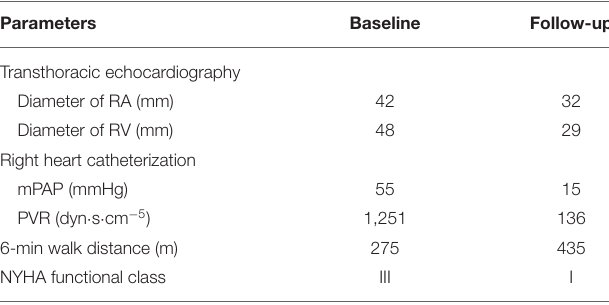
TABLE 1 | The baseline and follow-up parameters of the patient. Parameters